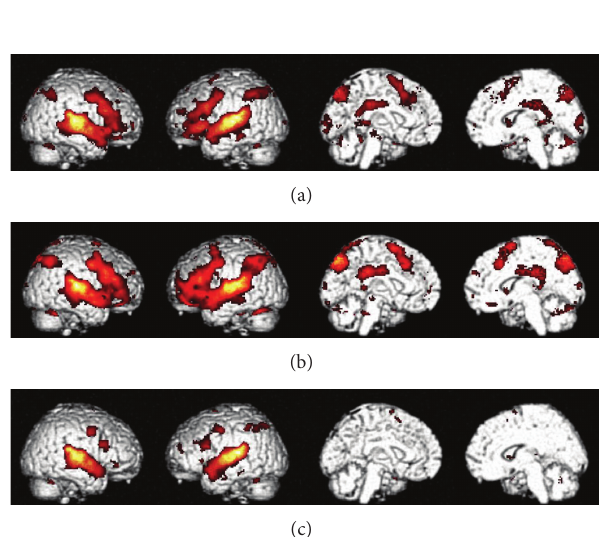
Figure 2: Cortical areas where the blood-oxygen-level dependent signals increased with the perceived emotion (a), felt emotion (b), and passive listening (c) tasks; voxel level after correction for false discovery rate ( 𝑝 < 0.05